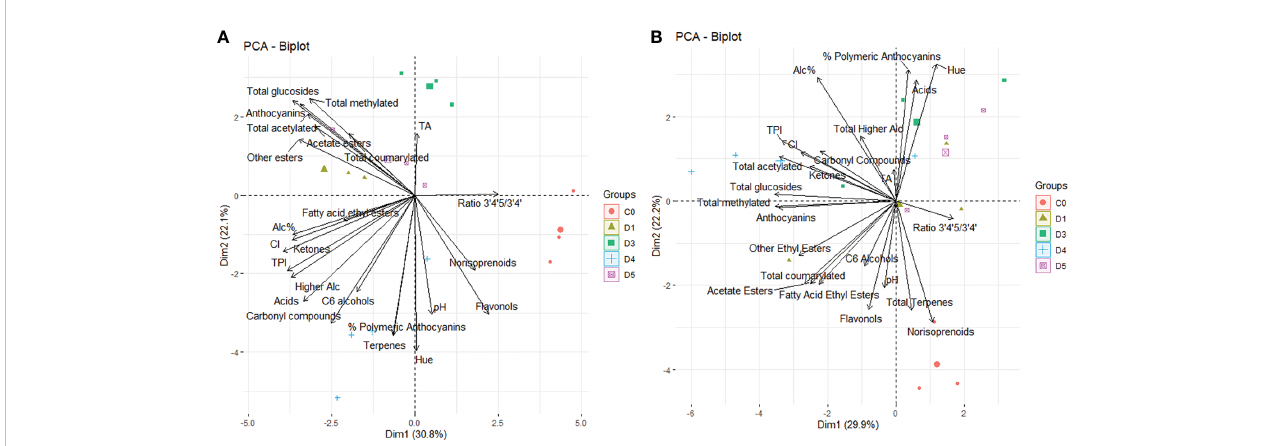
FIGURE 2 Principal component analysis (PCA) score and loadings plot obtained from the statistical analysis of wine characteristics, fl avonoid and aroma pro fi les of 15 wines from Cabernet Sauvignon grapevines subjected to partial solar radiation exclusion using 4 overhead shade fi lm treatments (D1, D3, D4, D5) and an uncovered control (C0) during the 2020 (A) and 2021 (B) growing